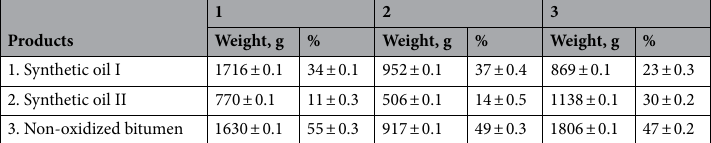
Table 2. Yield of products of synthetic oils after steam distillation of heavy